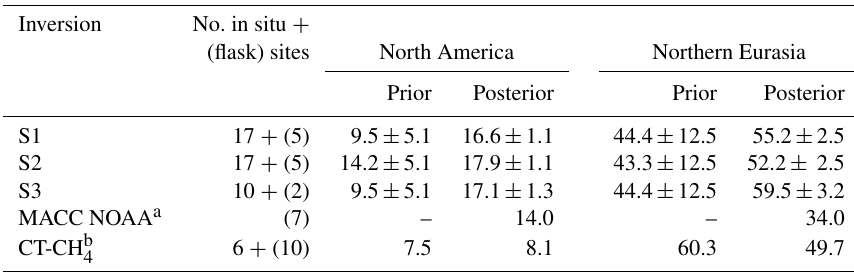
Table 3. Mean prior and posterior flux totals (units Tgyr − 1 ) for each inversion scenario and comparison to independent inversion estimates for 2005 to 2010 (the overlapping